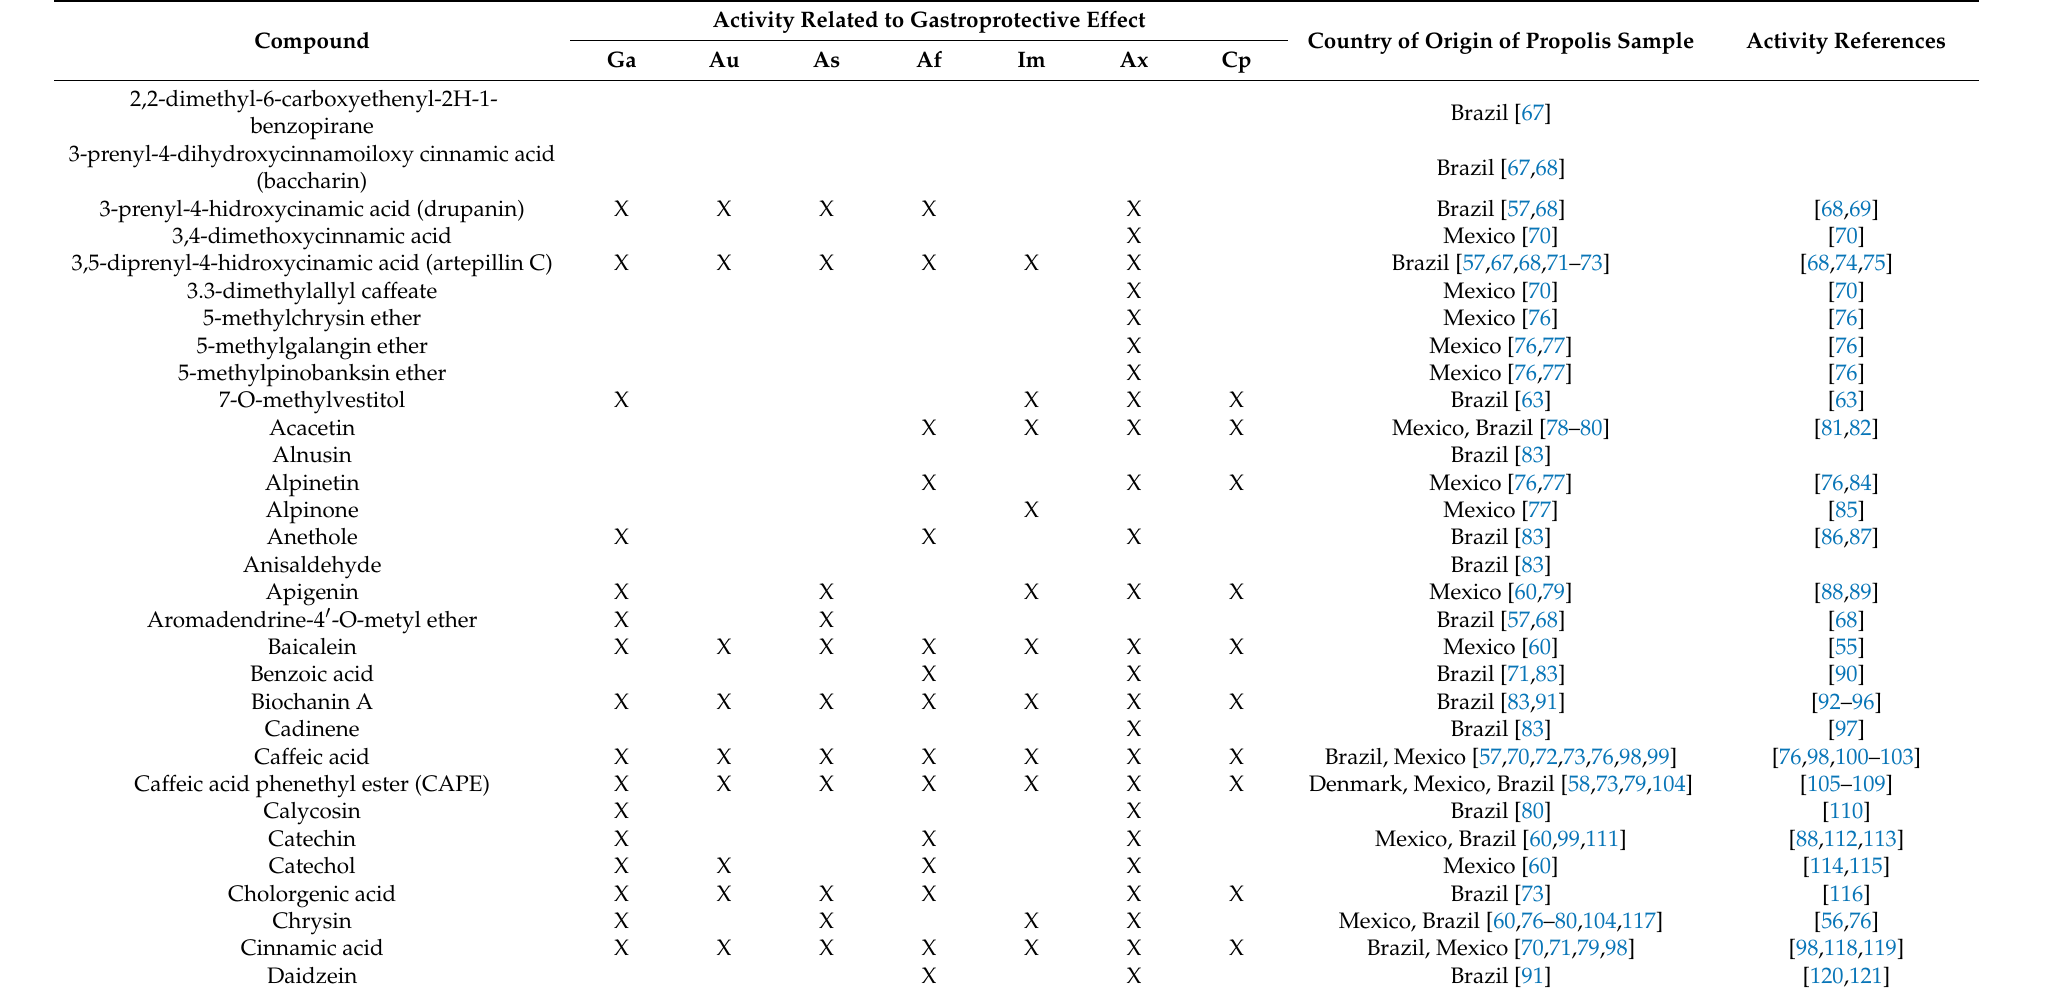
Table 2. Phenolic compounds identified in propolis with gastroprotective effect induced by